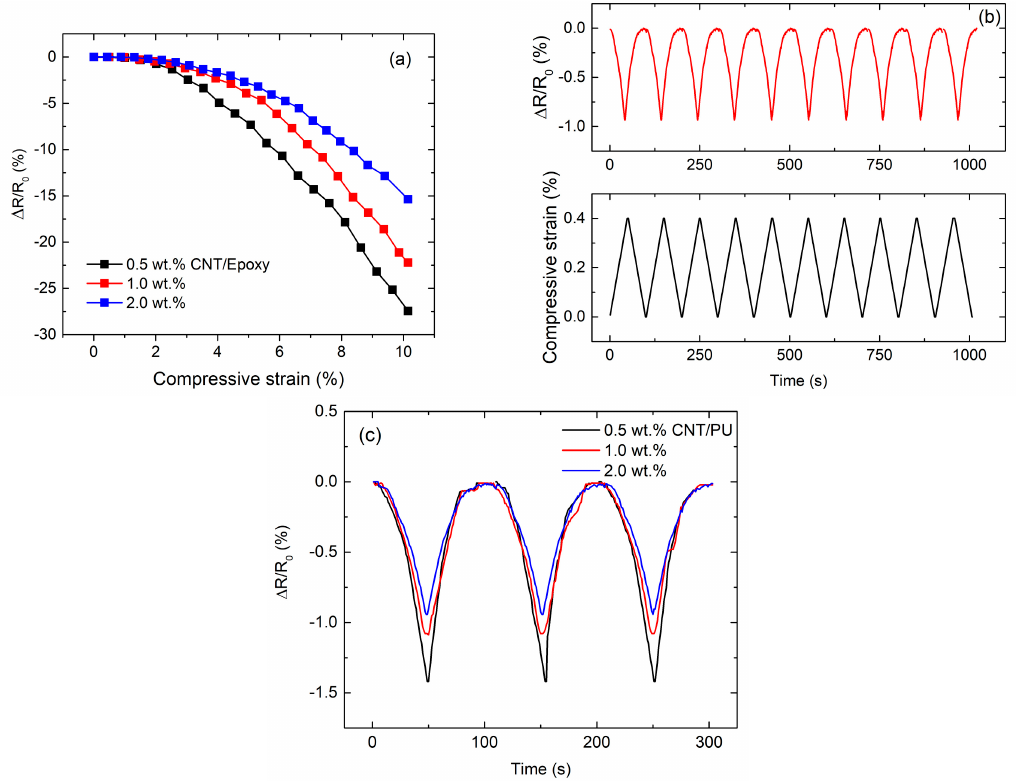
Figure 4. ( a ) Change in resistance of CNT / epoxy composites under static compressive loading; ( b ) electro-mechanical response of CNT / epoxy composites (2.0 wt %) under cyclic compressive loadings, ( c ) maximum peak at three cycles for all CNT / epoxy composites.